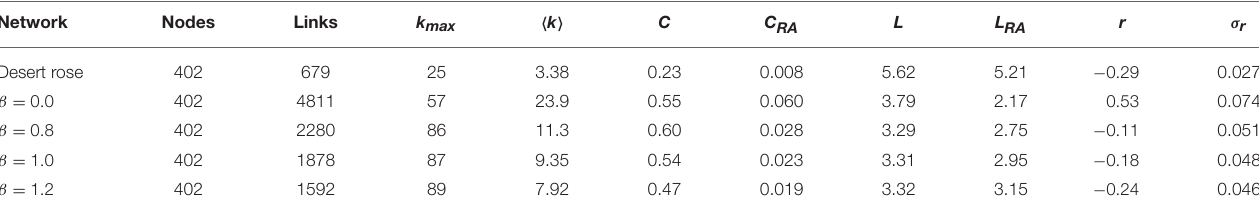
TABLE 1 | Average values of the number of nodes, links, maximum degree k max , average degree h k i , clustering coefficient C , clustering coefficient for random networks C RA , characteristic path length L , characteristic path length for random networks L RA , assortativity coefficient r with its standard deviation σ r for the desert rose and the desert rose model with four values of the parameter β .